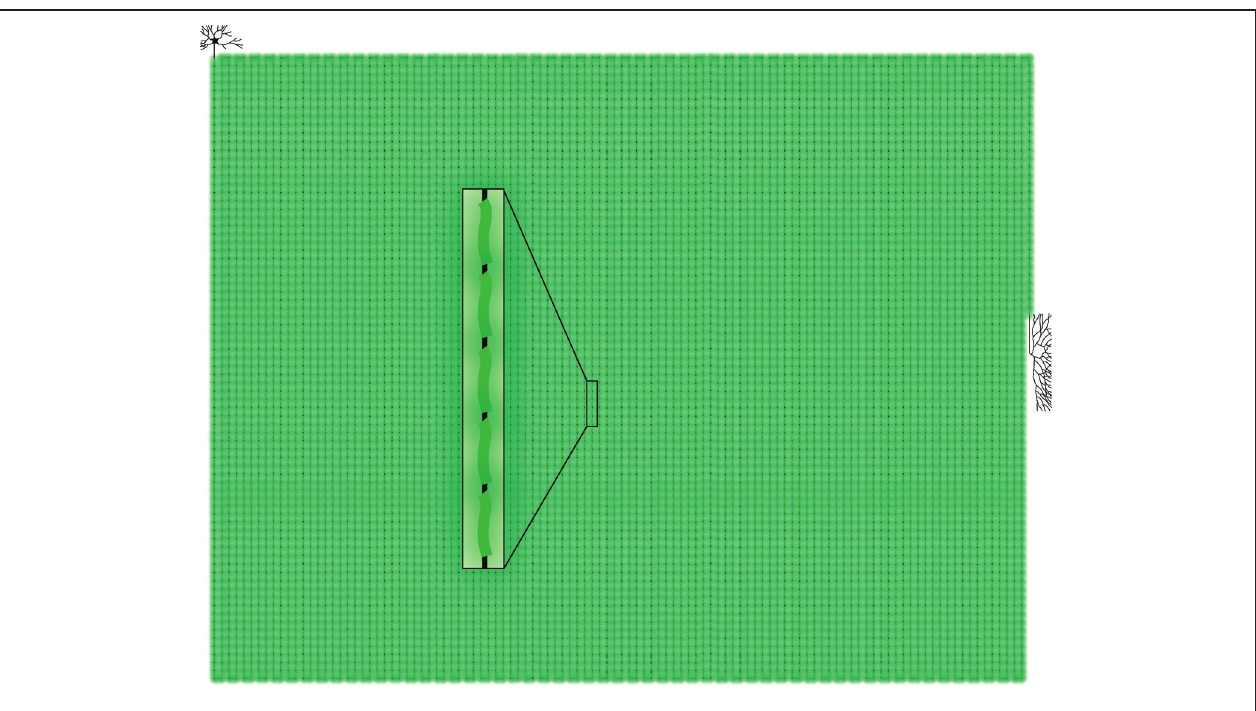
FIGURE 2 | Schematic illustration showing scaled model of human neuron/axon (black) in association with approximately 10,000 SCs (green) in proportionto size of neuronal soma and axon terminal .